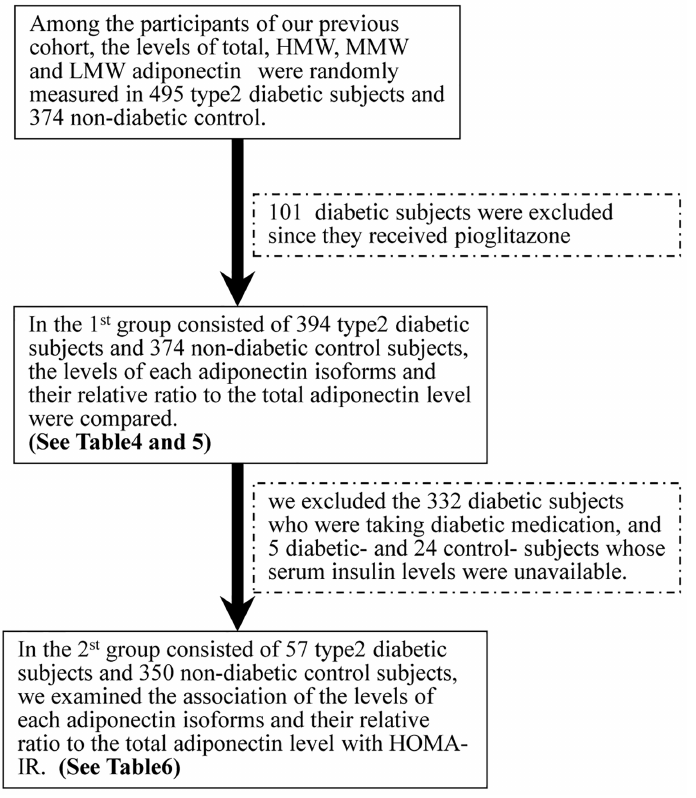
Fig 1. Selection of study subjects and analyses in the 1 st and 2 nd groups. HMW, high molecular weight; MMW, middle molecular weight; LMW, low molecular